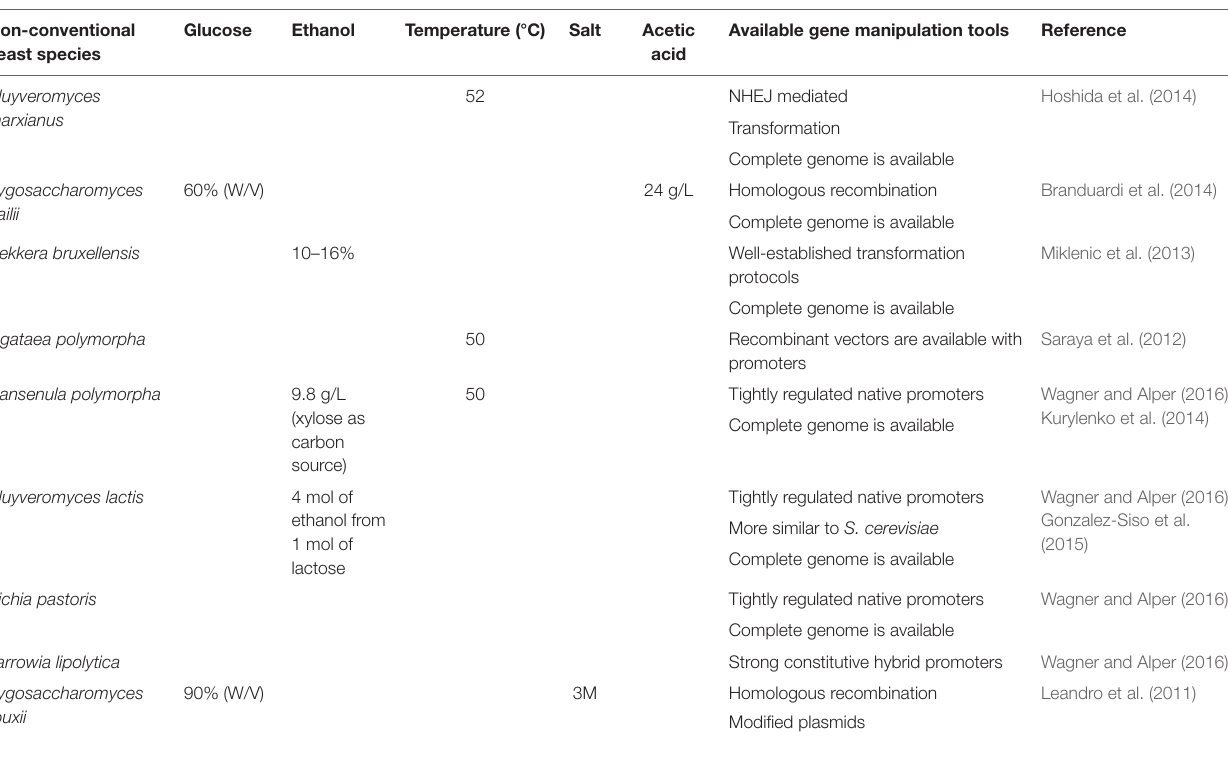
TABLe 1 | Non-conventional Yeasts and their characterestics and currently available genetic tools. Non-conventional yeast